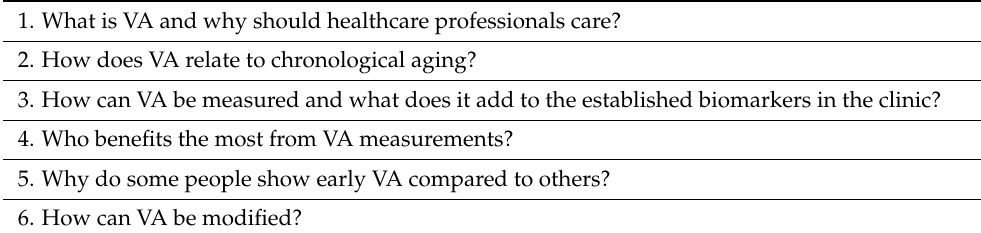
Table 1. The six main questions/topics around VA originally identified by the expert focus